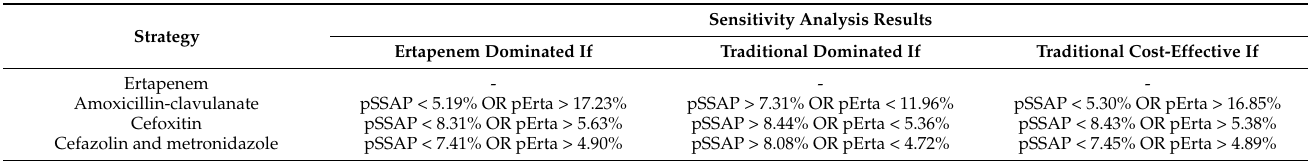
Table 3. Results of the univariate sensitivity analysis comparing ertapenem to standard prophylactic regimens for elective colorectal